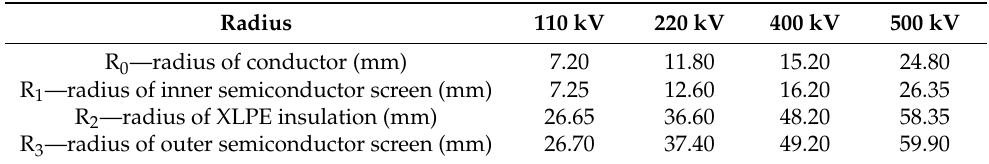
Table 1. Geometrical parameters of semiconductor screens and pure XLPE insulation used to calculate the electric field distribution and dielectric losses in high-voltage cables [5,55,60,61]. Radius 110 kV